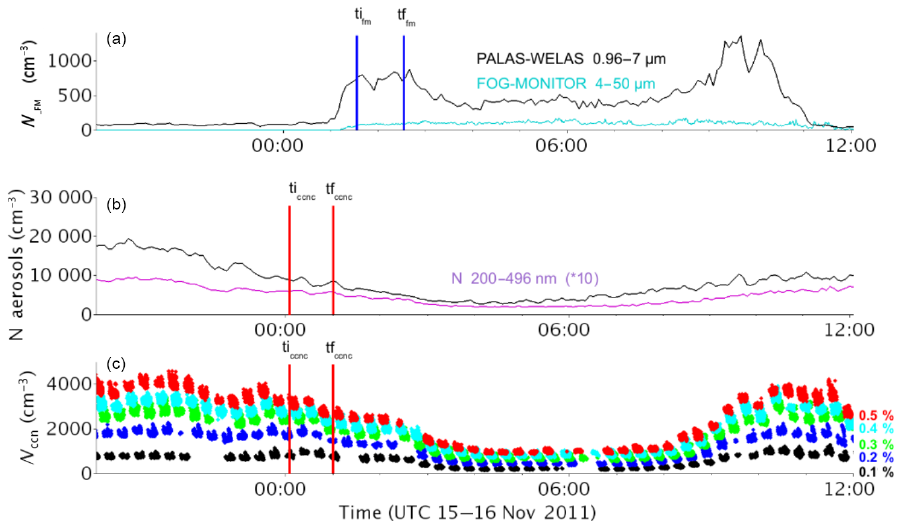
Figure A2. Time series of measurements for the f6 case: (a) particle number concentration at ambient humidity from FM-100 (cyan) and WELAS (black); (b) dry particle number concentration from SMPS: total (black) and particle with diameter > 200nm (purple); and (c) N ccn from the CCN chamber at each supersaturation with color as indicated on the label. Vertical segments indicate the selected time periods before (red) and during (blue) the beginning of the fog